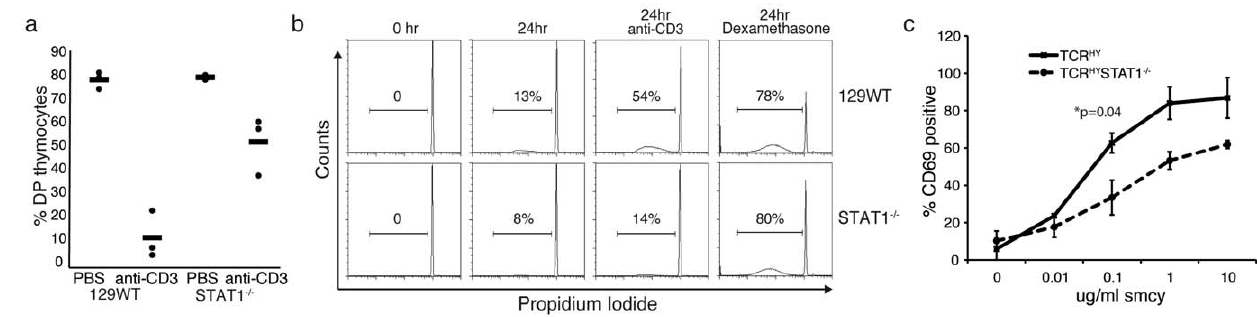
Figure 3. STAT1-deficient thymocytes fail to undergo TCR induced apoptosis. ( a ) Mice were injected i.p. with 20 m g anti-CD3 antibody, and analyzed 48 hours post injection. The percentages of CD4 + CD8 + double-positive (DP) cells in WT and STAT1 2 / 2 mice are shown with and without anti-CD3 antibody injection. Results shown represent three mice each. ( b ) Flow-cytometry of PI-stained WT or STAT1 2 / 2 thymocytes in culture. Double positive thymic T cells were stimulated with plate bound anti-CD3 for 24 hours, or treated with dexamethasone for 24 hours, and the sub- G 0 G 1 DNA content of nuclei measured by flow cytometry. Results shown represent averages at least three experiments. c ) Double positive thymocytes from female TCR HY and TCR HY STAT1 2 / 2 mice were incubated with indicated concentrations of smcy peptide and analyzed 18 hours later for CD69 expression. Average and standard deviations from 3–4 mice are shown.